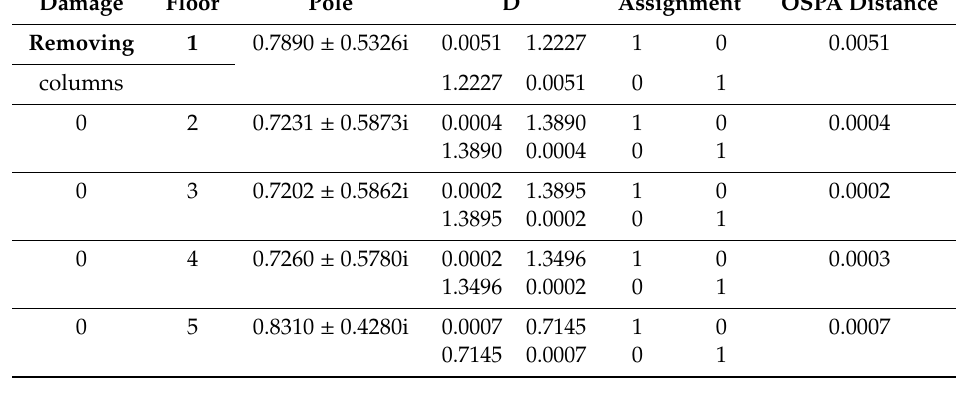
Table 7. OSPA distance and the corresponding parameters for the case of removing columns on the first